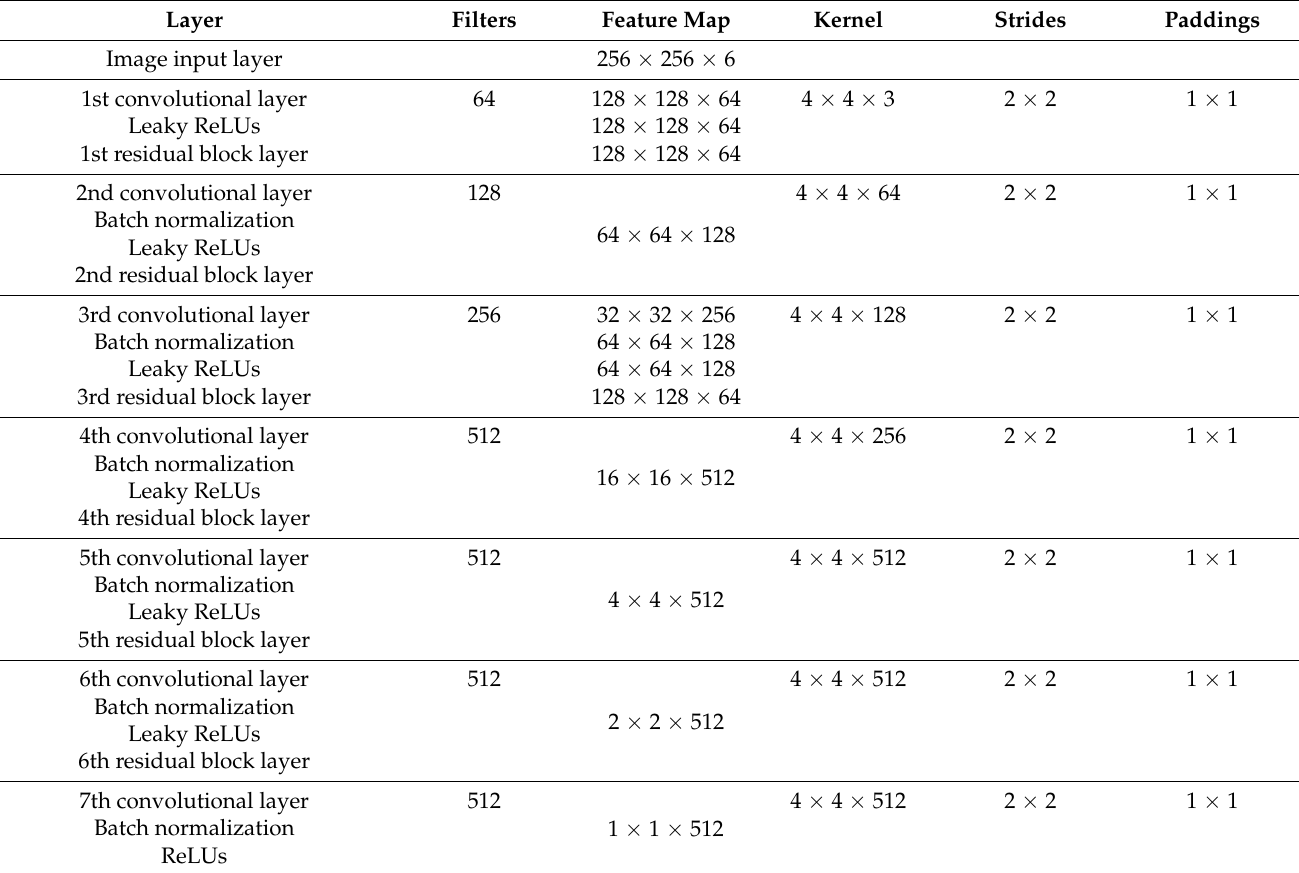
Table 1. Encoder parameters of the proposed generator network.